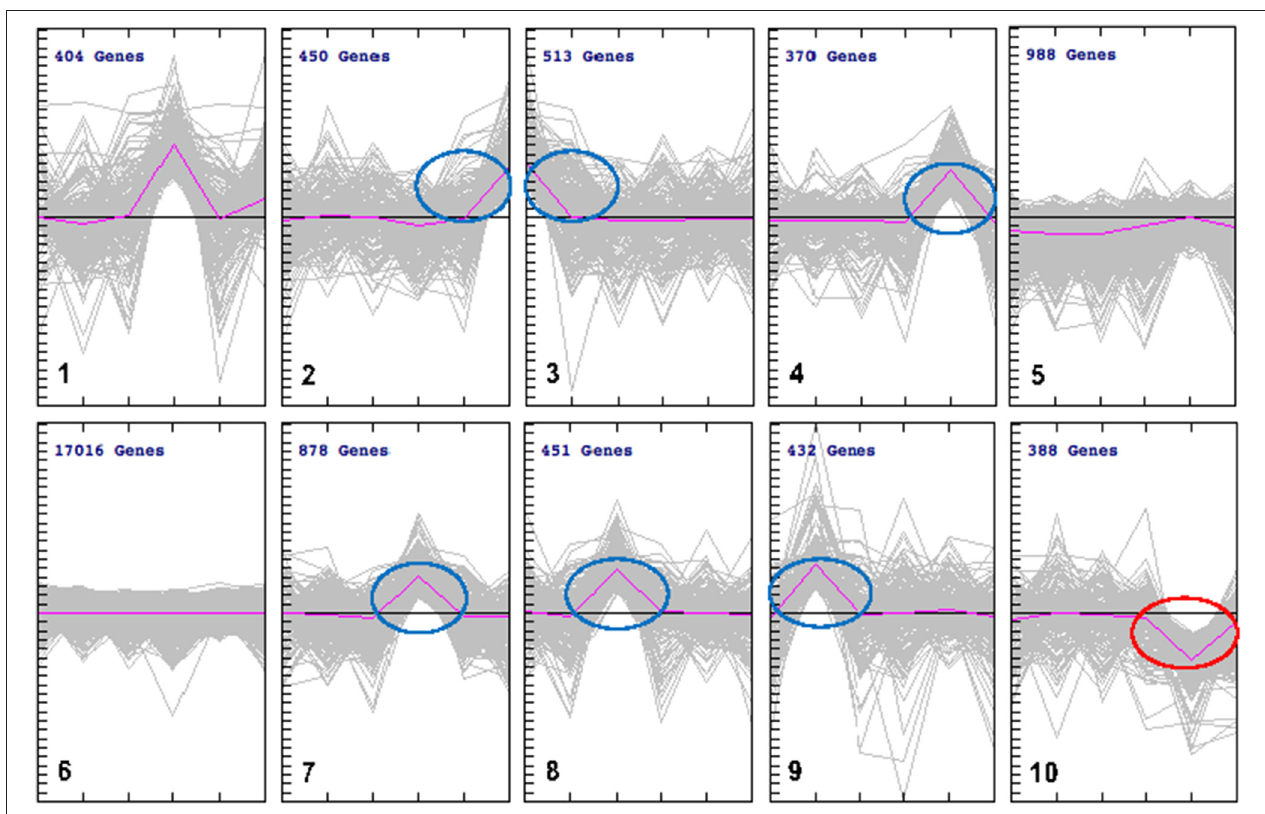
FIGURE 4 | k-Means clustering patterns of the differentially expressed genes across cat tissues. All DEGs were clustered into 10 groups using k-means clustering method and visualized with TM4 software. The pink line shows average expression z-scores to visualize the dominant expression trend of each cluster. Each line in the figure represents an expression value of the corresponding gene. The horizontal axis indicates the type of cat tissues and the vertical axis is the log2 expression ratio. Fold expression changes between various tissues from infected and uninfected cats were calculated using the log2 ratios. The numbers of genes for each cluster are indicated. The clusters included DEGs whose expression was either up regulated (clusters 2, 3, 4, 7, 8, and 9) or down regulated (cluster 10). There were no changes in gene expression observed in clusters 5 and 6. DEGs in cluster 1 was not considered due to lack of specificity to a single